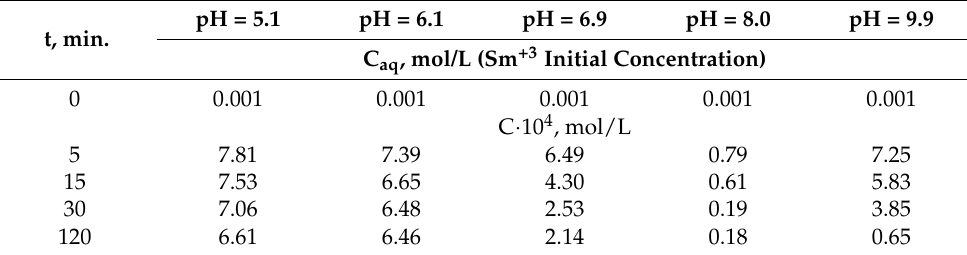
Table 3. Sm 3+ concentration change in the aqueous phase during solvent sublation. t, min.